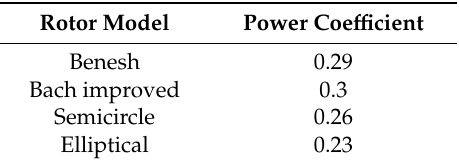
Table 2. Experimental results for tested rotor models [9].